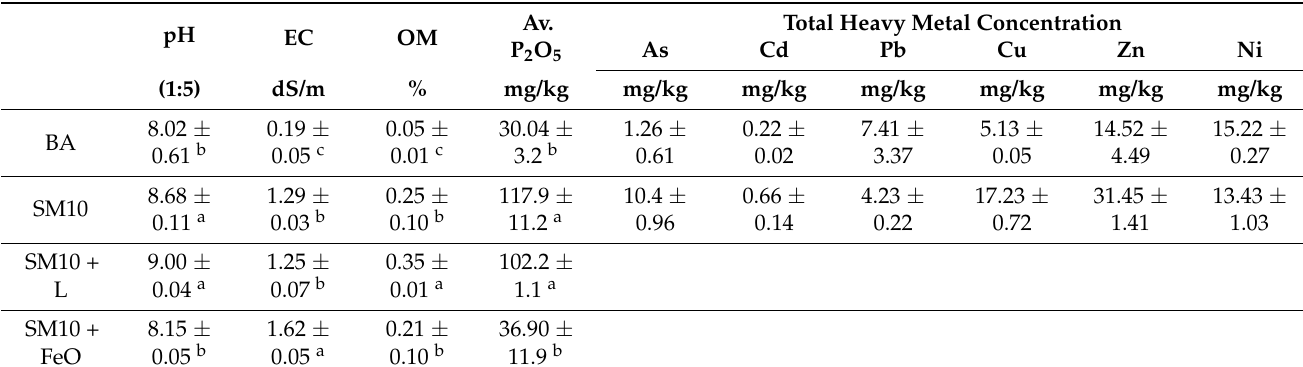
Table 1. Physicochemical properties of